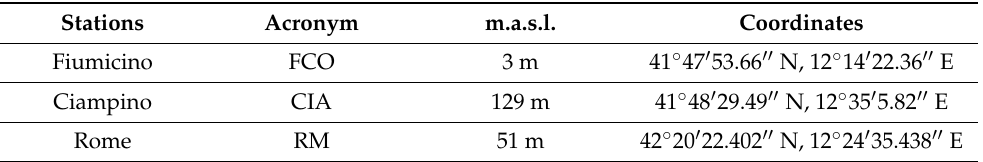
Table 1. Description of the stations used.